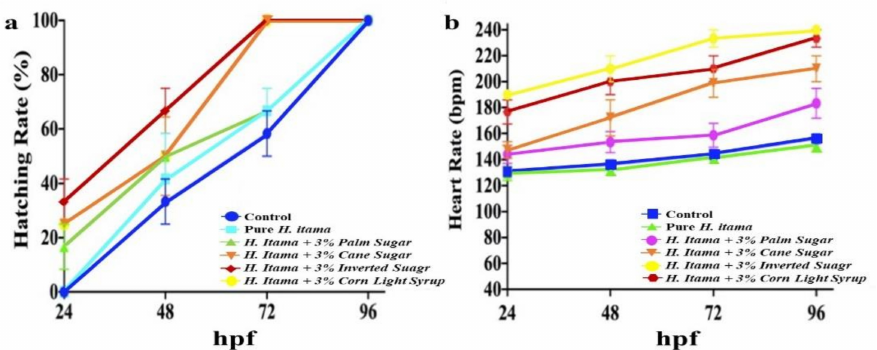
Figure 2. Concentration and time-dependent effect of pure H. itama honey on zebrafish embryos: ( a ) hatching rates and ( b )